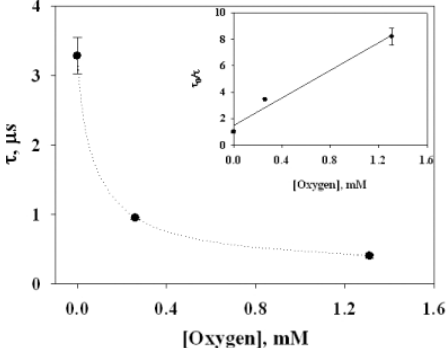
Fig. 9. Standard curve of phosphorescence lifetime vs con- centration of oxygen in bu®ers saturated with nitrogen ( ½ O 2 (cid:7) ¼ 0), air ( ½ O 2 (cid:7) ¼ 0 : 26 mM) and oxygen ( ½ O 2 (cid:7) ¼ 1 : 31 mM) estimated by the epi-phosphorescence-TCSPC method. Stan- dard deviations of 0.26, 0.02, and 0.02 were obtained respect- ively for the three values as estimated from eight independent measurements (shown as error bars). The inset shows the Stern – Volmer plot, namely (cid:2) 0 =(cid:2) ¼ 1 þ (cid:2) 0 k q [O 2 ], where (cid:2) 0 and (cid:2) are the phosphorescence lifetimes in the absence and the presence of quencher respectively and k q is the bimolecular quenching constant. The estimated value of k q ð¼ 1 : 46 (cid:5) 10 9 M (cid:2) 1 s (cid:2) 1 ) is close to di®usion-controlled values as expected. Reproduced from Williams et al. , 48 with permission.